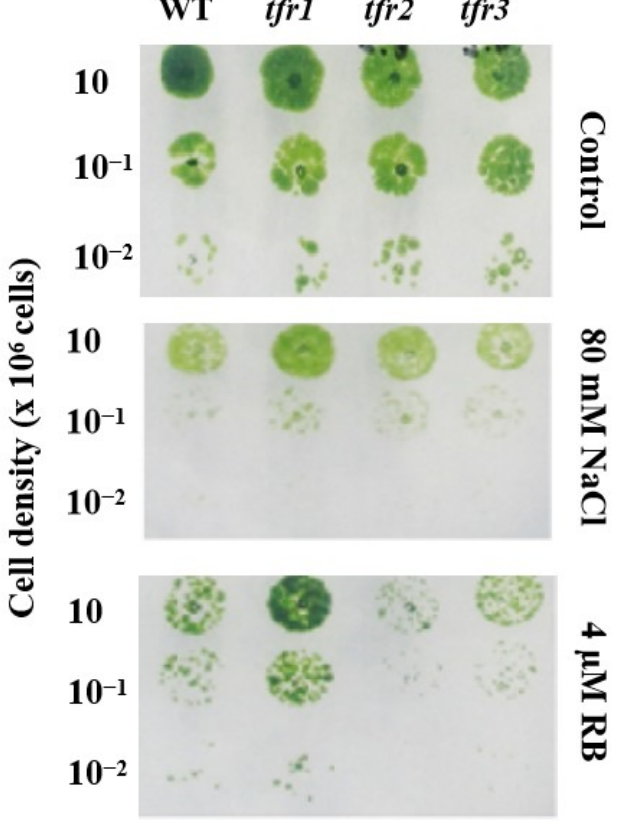
Figure 5. Growth phenotype wild type (WT) and tfr1 under oxidative stress. Serial dilutions of cells were spotted onto the agar medium NaCl and Rose Bengal (RB) and cultivated for 1 week.